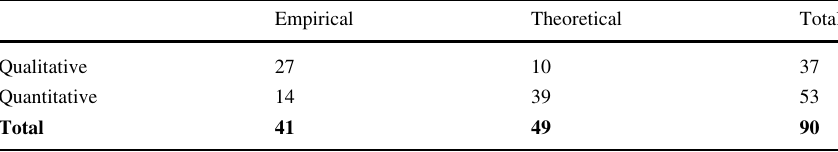
Table 3 Distribution of papers over research methodologies